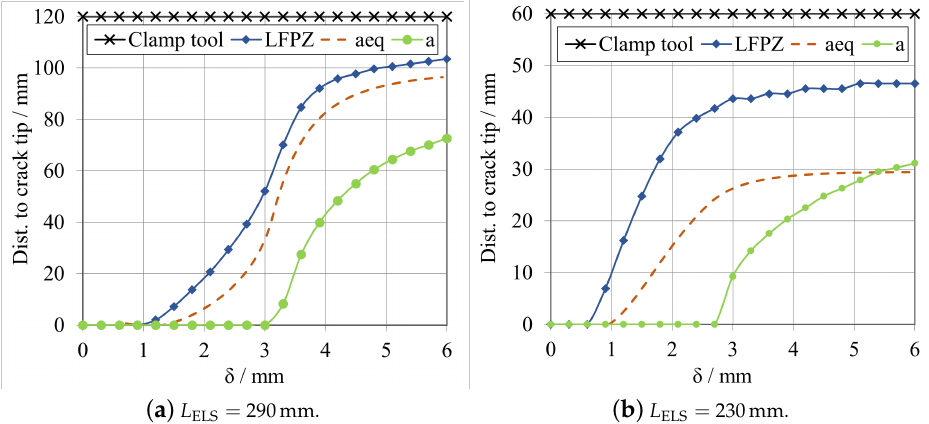
Figure 16. Study of L FPZ , a eq and a for the brittle adhesive, with a 0 ELS =